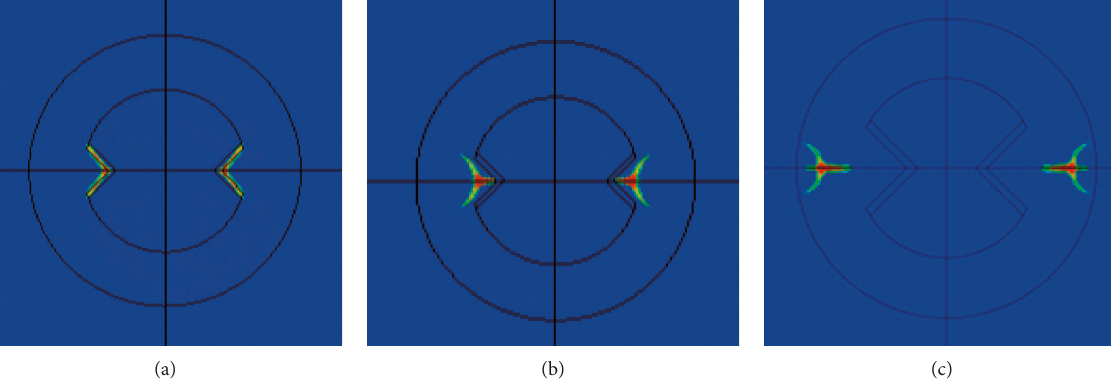
Figure 5: Process of shaped charge jet formation and migration under cumulative blasting with decoupling coefficient 1.67m: (a) t � 4.97 μ s;